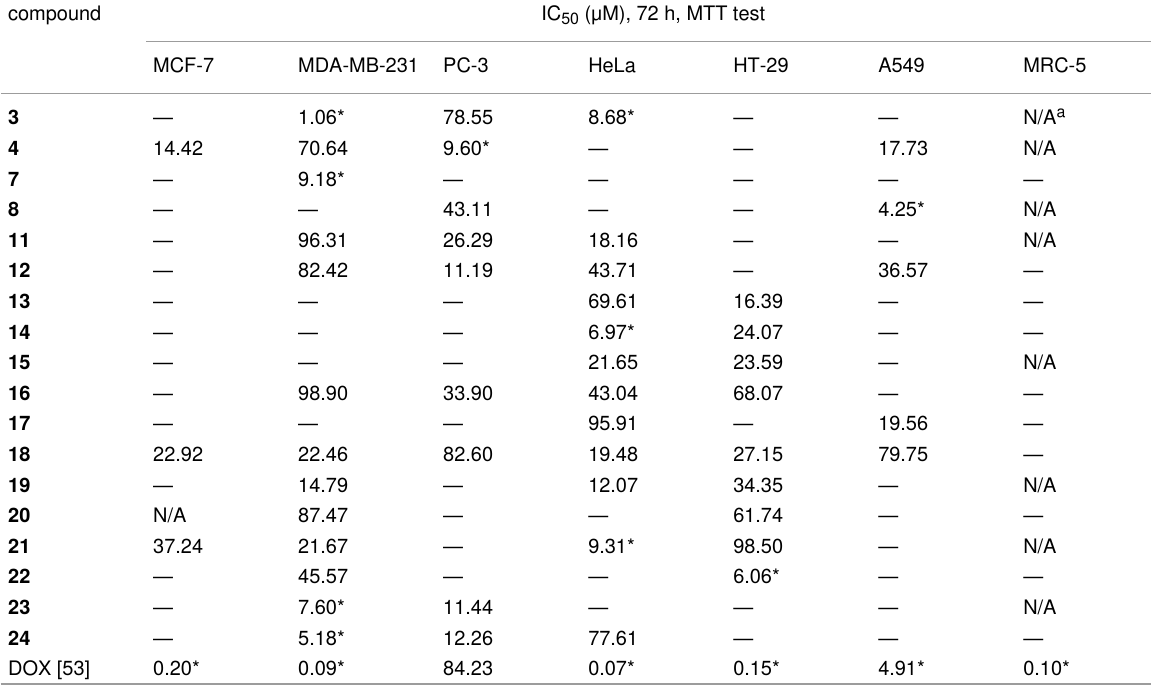
Table 4: Results of antiproliferative activity testing (IC 50 values less than 10 μ M are marked with an asterisk, while a dash denotes an IC 50 value higher than 100 μ M). compound